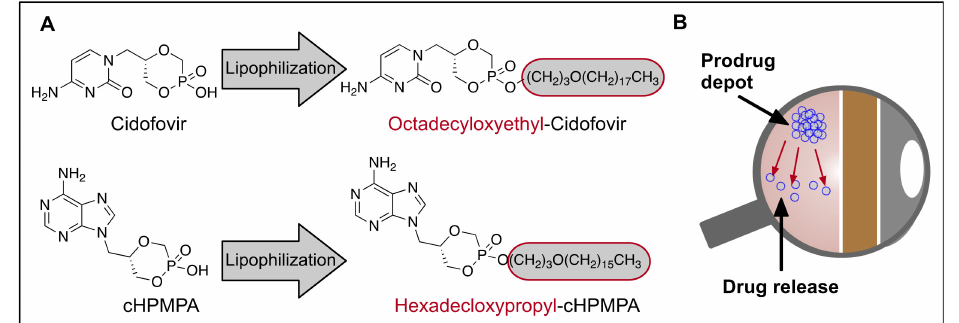
Figure 8. Lipid prodrugs have successfully been used to prolong the vitreal half-life of small hydrophilic compounds. ( A ) Conjugation of cyclic Cidofovir to a lipophilic chain and lipophilization of cHPMPA results in the formation of a depot after intravitreal injection which lasts significantly longer than vitreous retention times. ( B ) After injection of lipophilic prodrugs, a depot forms within the eye from which the drug is slowly